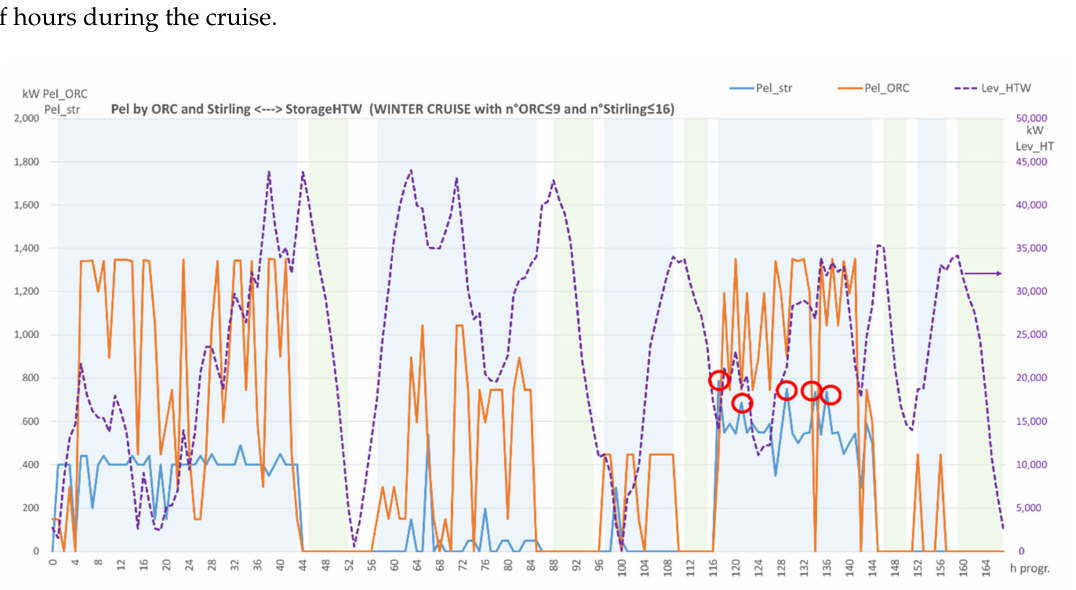
Figure 13. An example of optimized management, with 16 Stirling groups for the winter case; in the red circles the time interval of the cruise during which 16 or 15 or 14 Stirling groups are actually